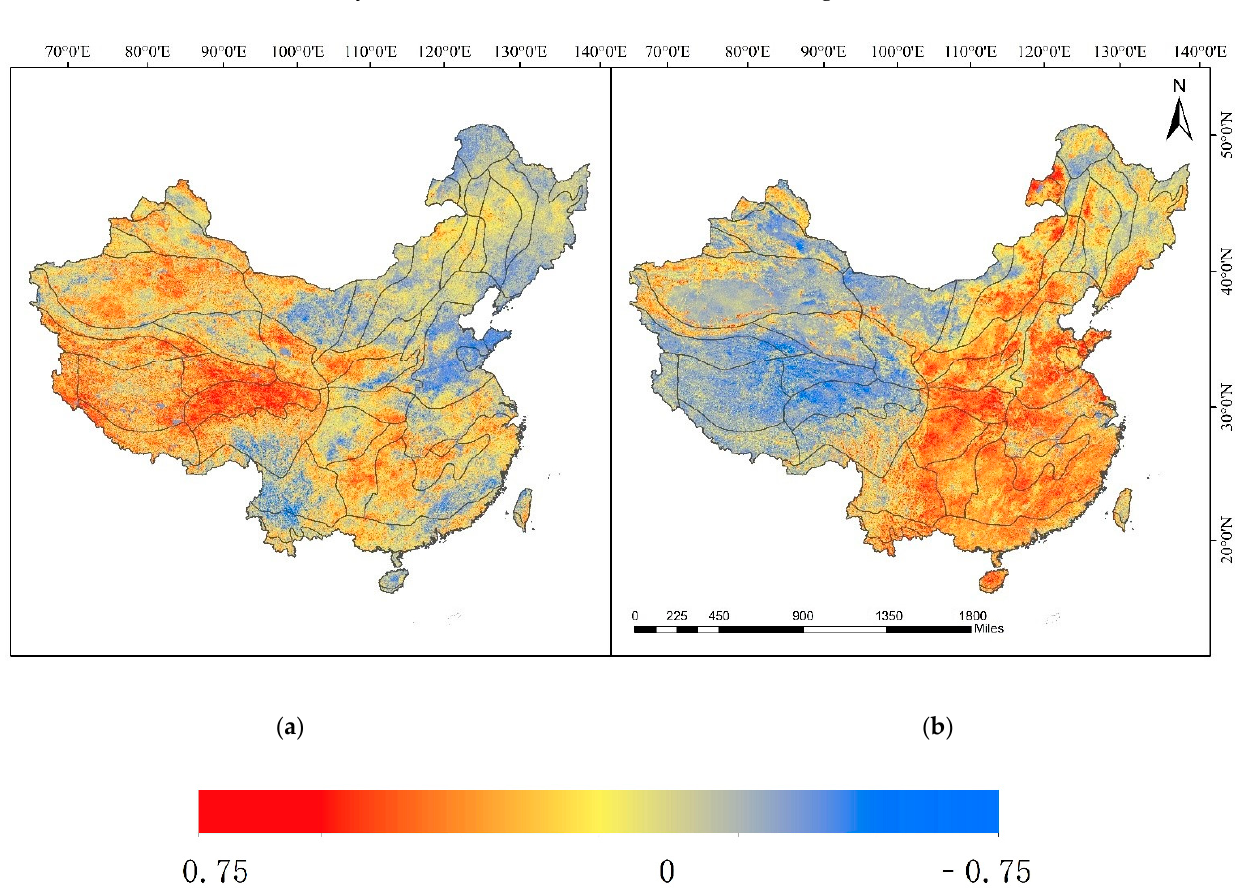
Figure 3. Correlation between remote sensing drought indices and ENSO (Except the South China Sea Islands): ( a ) spatial distribution of the correlation coefficient between TCI and Niño 3.4; and ( b ) spatial distribution of the correlation coefficient between VCI and Niño 3.4.